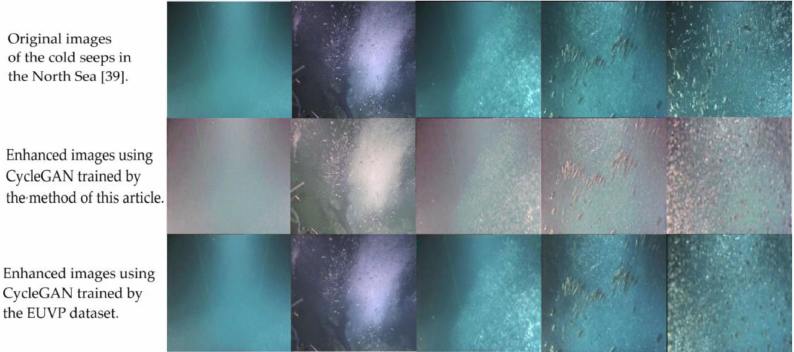
Figure 7. Results for the trained CycleGAN’s enhancement of images in the North Sea